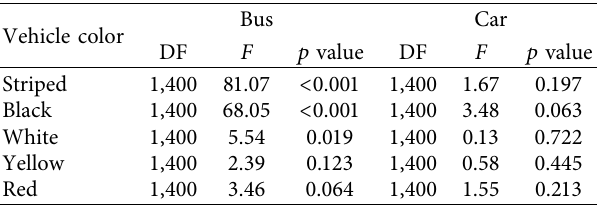
Table 5: Effects of lighting conditions under the front identification